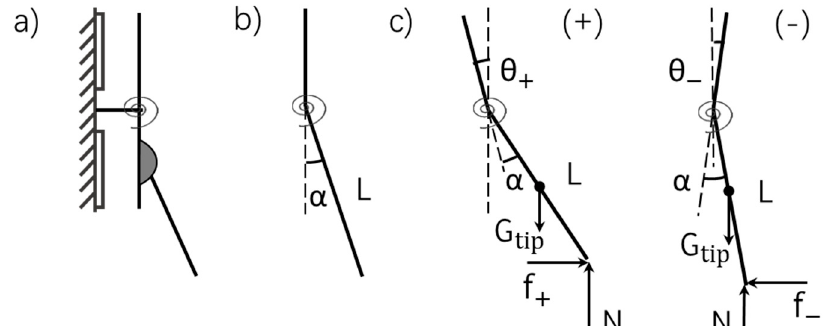
Figure 5. Geometric illustration of the coupling from the teeter-totter structure. ( a ) A side view model of the teeter-totter structure with a tip connected on the plate by glue; ( b ) A simplified model from ( a ); ( c ) Two common situations (forward and backward) during the friction measurements.